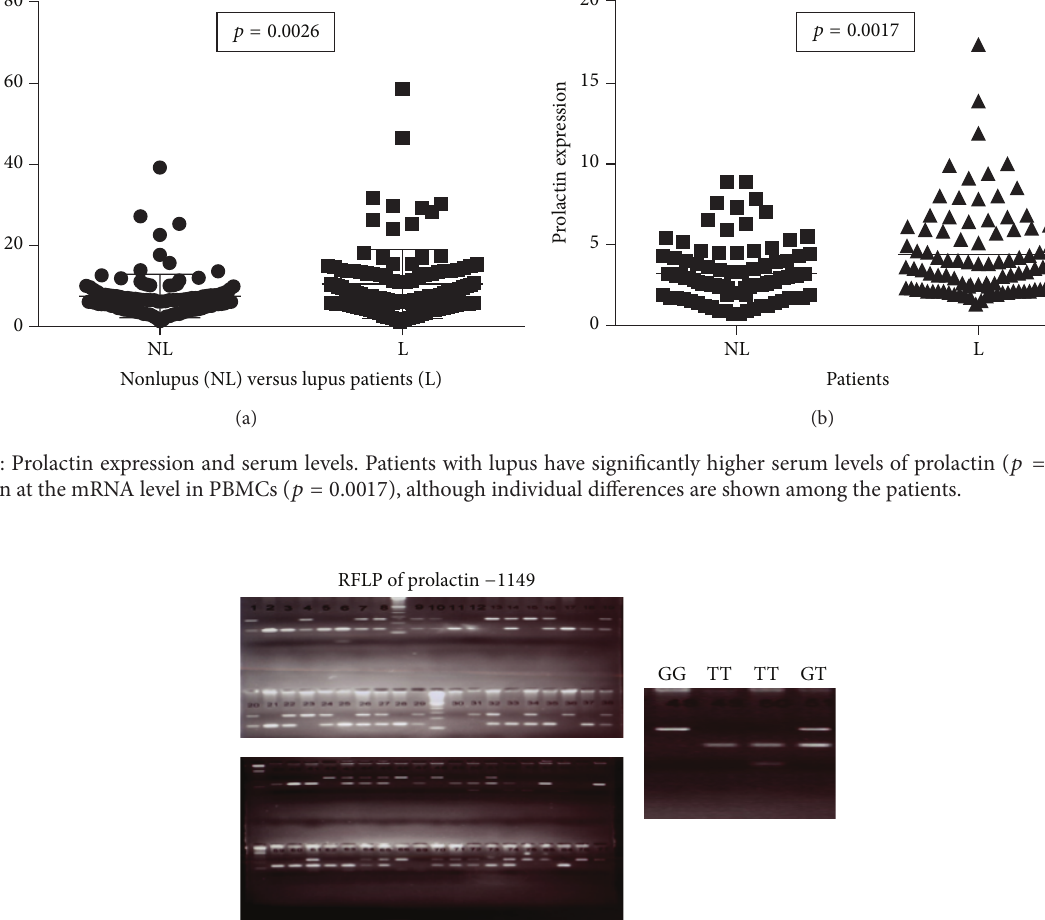
Figure 3: Restriction fragment length polymorphism (RFLP) of prolactin − 1149. RFLP analysis with ApoI digestion yields three fragment lengths to distinguish the three genotypes, GG, GT, and